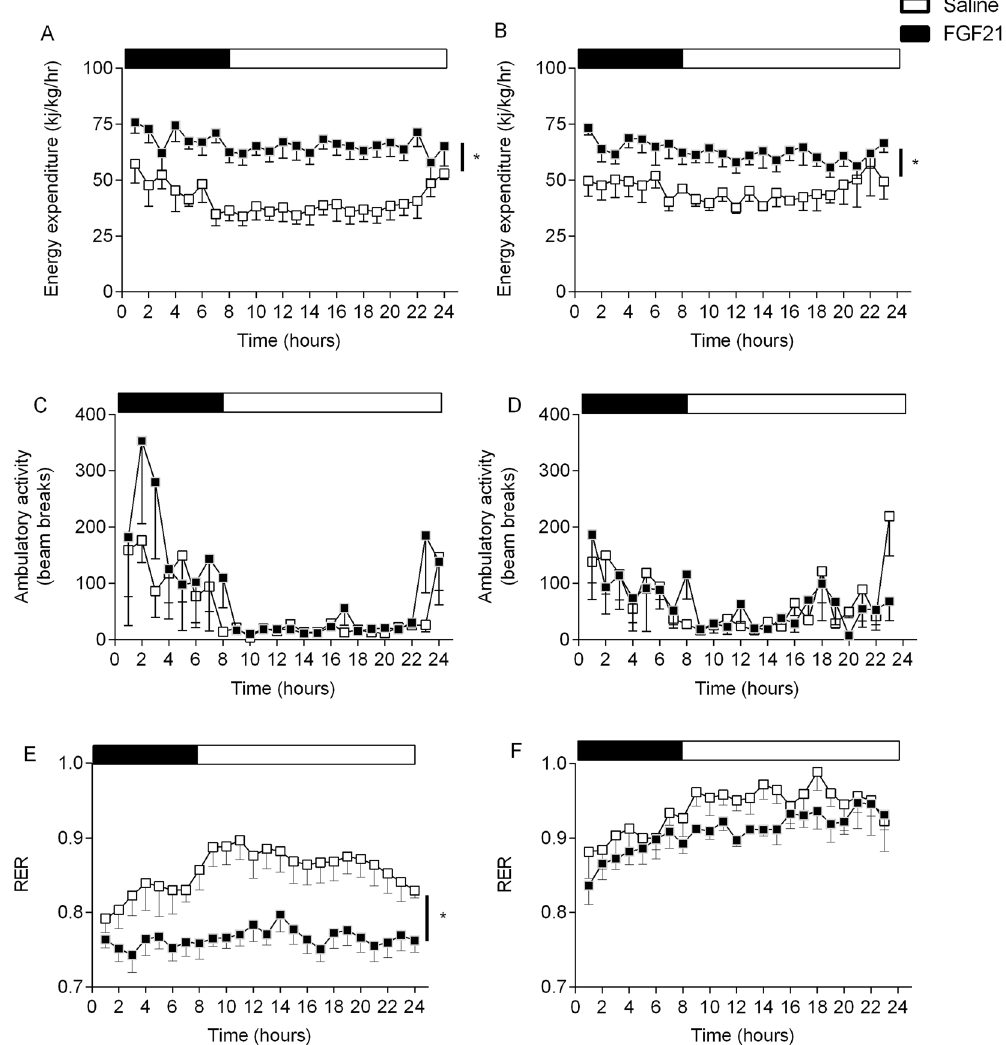
Figure 3. Treatment with FGF21 increases energy expenditure but fails to reduce RER in the aged cohort of Siberian hamsters. Energy expenditure ( A and B ), ambulatory activity ( C and D ) and RER ( E and F ) of young and aged Siberian hamsters treated with vehicle (saline) or FGF21. Values are group mean ± SEM, n = 5–6 per treatment: * p <